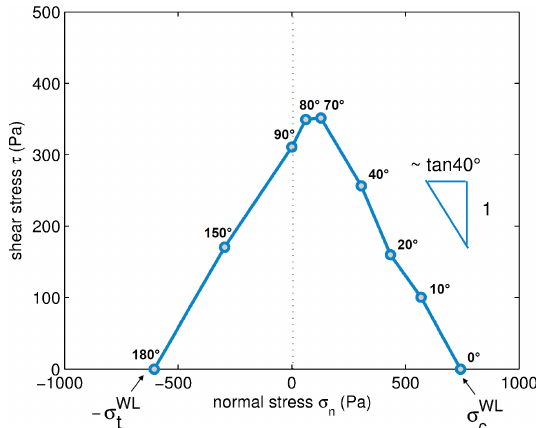
Figure 6. Failure envelope of the modeled WL obtained from mixed-mode shear-compression loading tests. The angle repre- sented next to the data points is the slope angle, σ WL t and σ WL c are the tensile and compressive strengths,